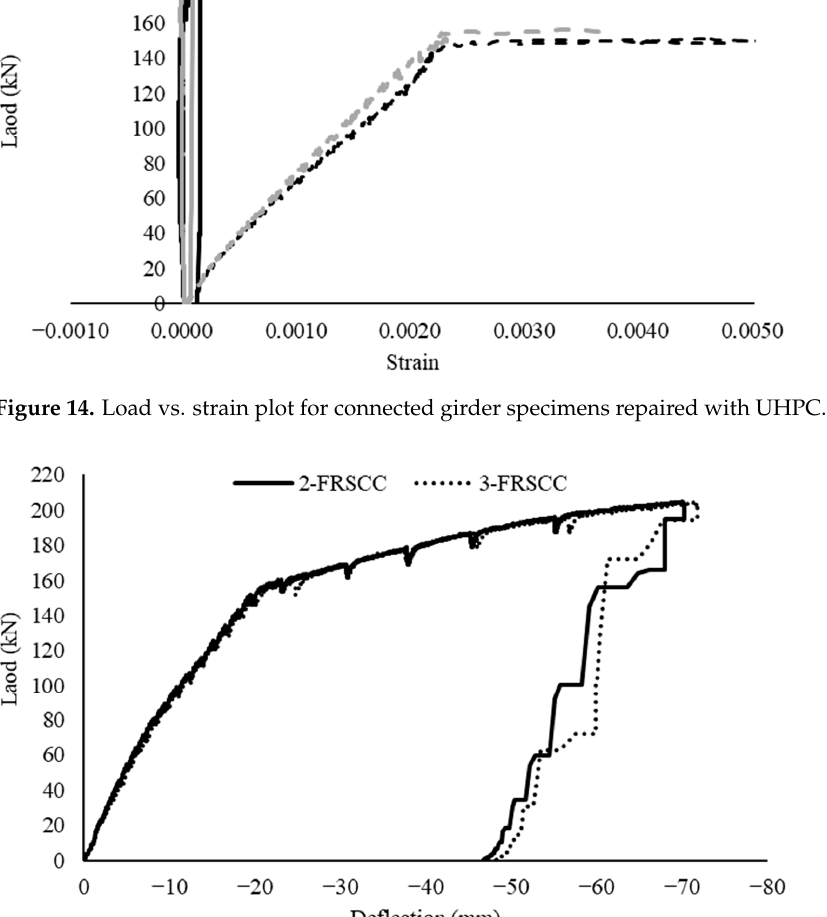
Figure 16. Load vs. strain plot for connected girder specimens repaired with FRSCC.